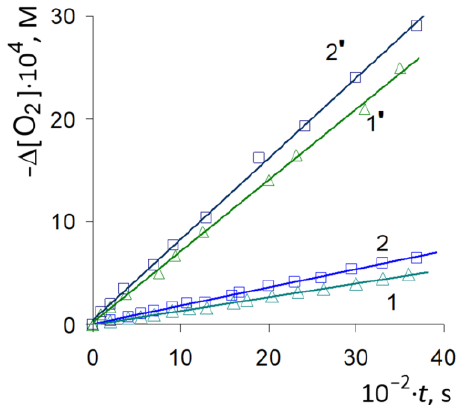
Figure 4. Kinetics of oxygen consumption during the oxidation of adrenaline. [AAPH] = 4·10 − 3 M; [Adr] 0 = 1·10 − 3 M; H = 9.0; 310 K. Carbonate buffer: [SOD] 0 = 100 U/mL (1 ’ Δ ), [SOD] 0 = 0 U/mL (2 ’